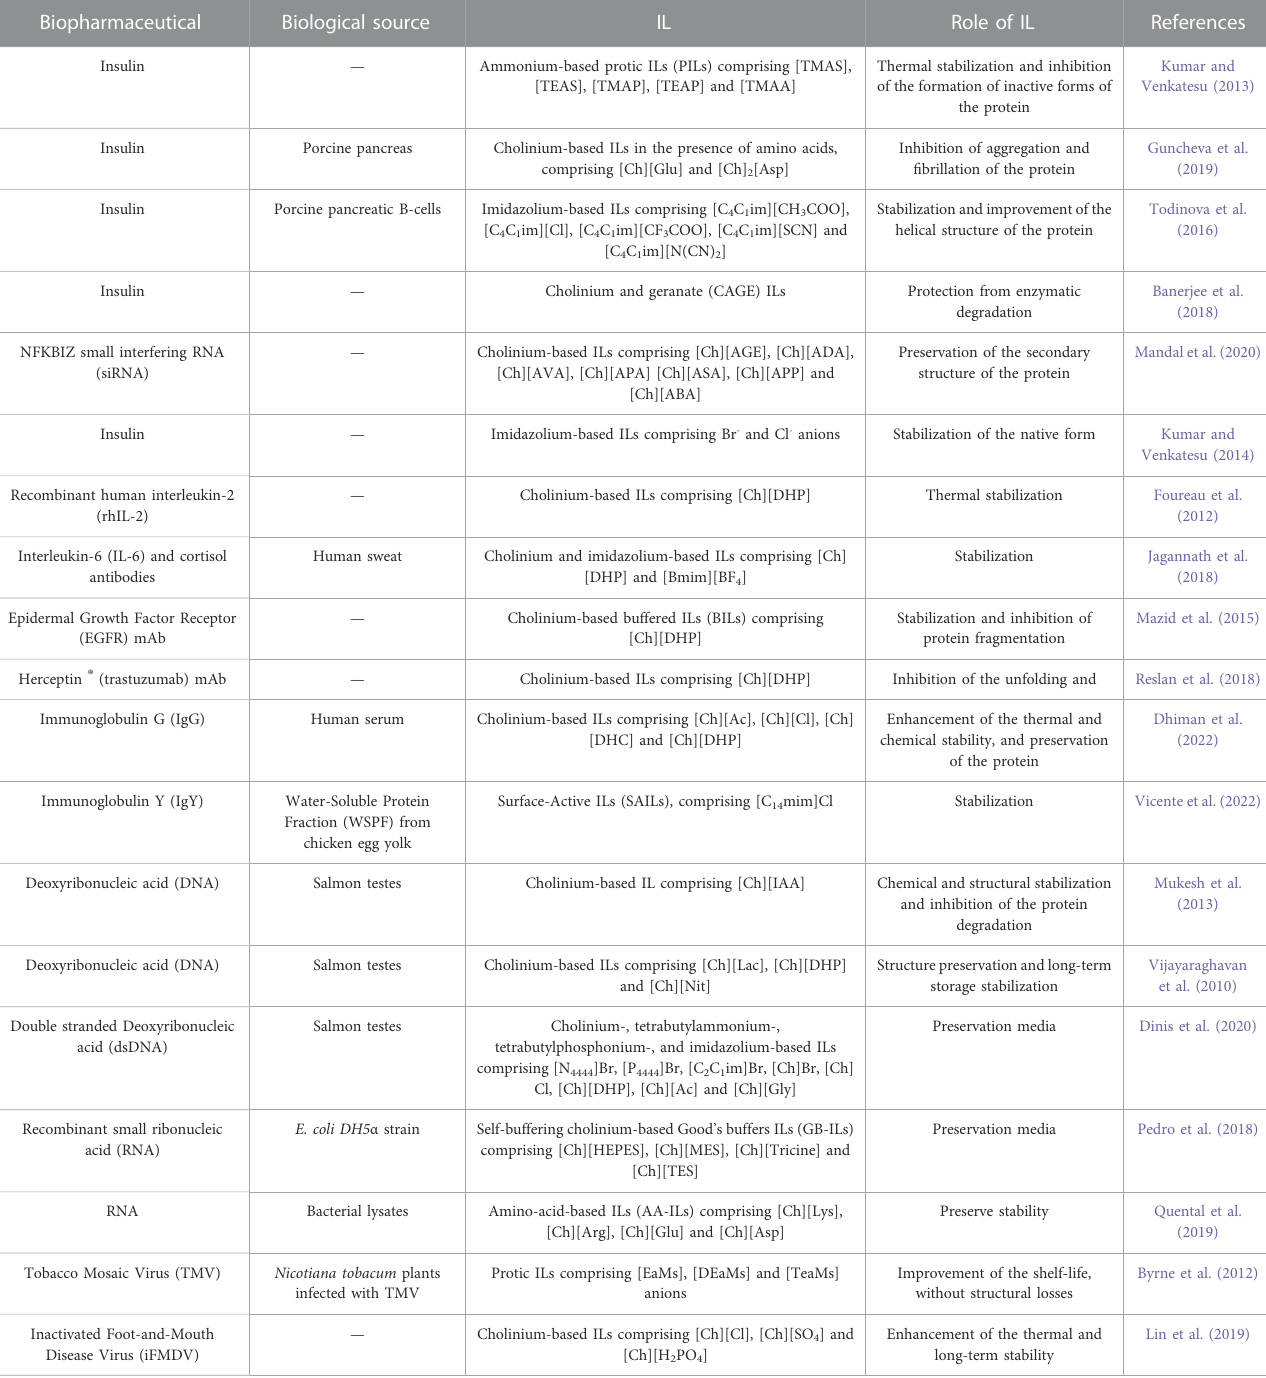
TABLE 3 Representative works regarding the use of ILs in biopharmaceutical formulations.